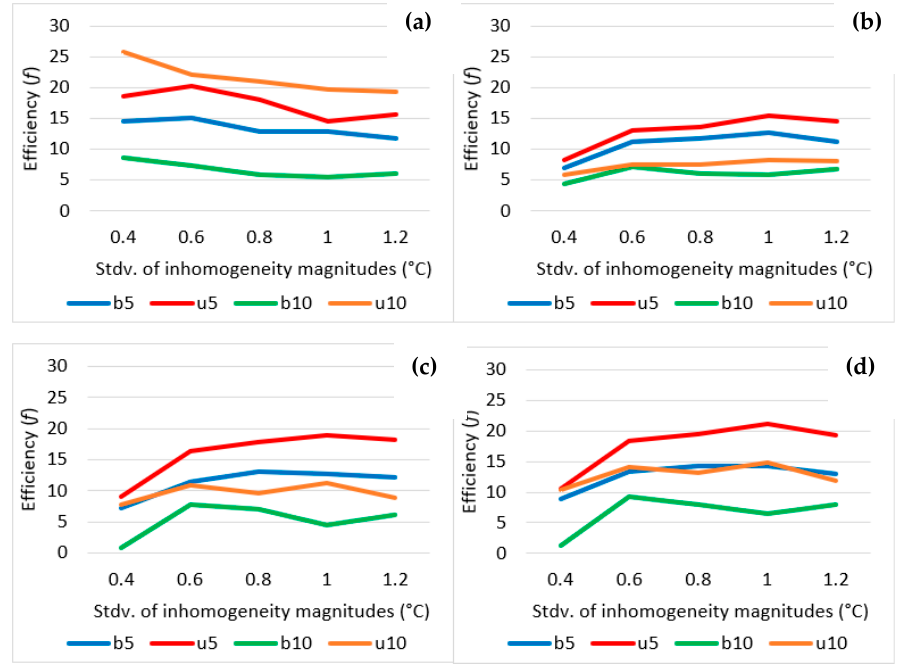
Figure 6. The same as Figure 4, but here the efficiencies are shown in the function of the standard deviation of inhomogeneity magnitudes. Note that only the parameter modulating the magni- tudes of breaks and gradually changing inhomogeneities is varied, while the standard deviation of short platform inhomogeneities is fixed (0.6 ◦ C). Upper left panel ( a ) CRMSEm, upper right panel ( b ) CRMSEy, bottom left panel ( c ) Trend bias for individual time series (Trbias), bottom right panel ( d ) Network mean trend bias